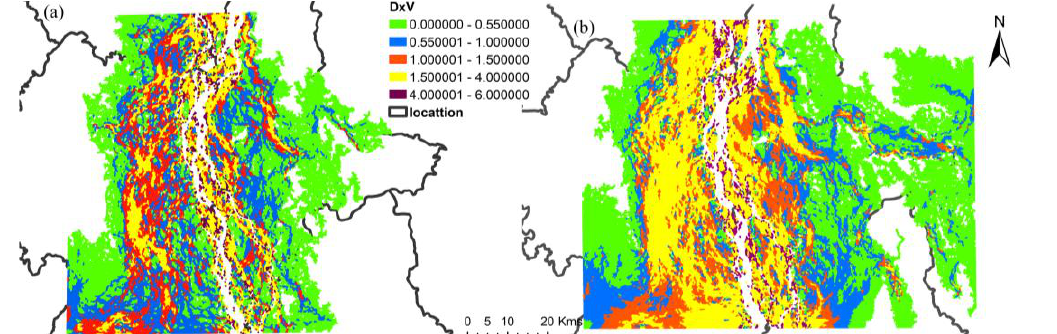
Fig. 8. Flood hazard mapping based on the product of maximum velocity and depth, (a) for 2 yrs return period, (b) for 100 yrs return period.